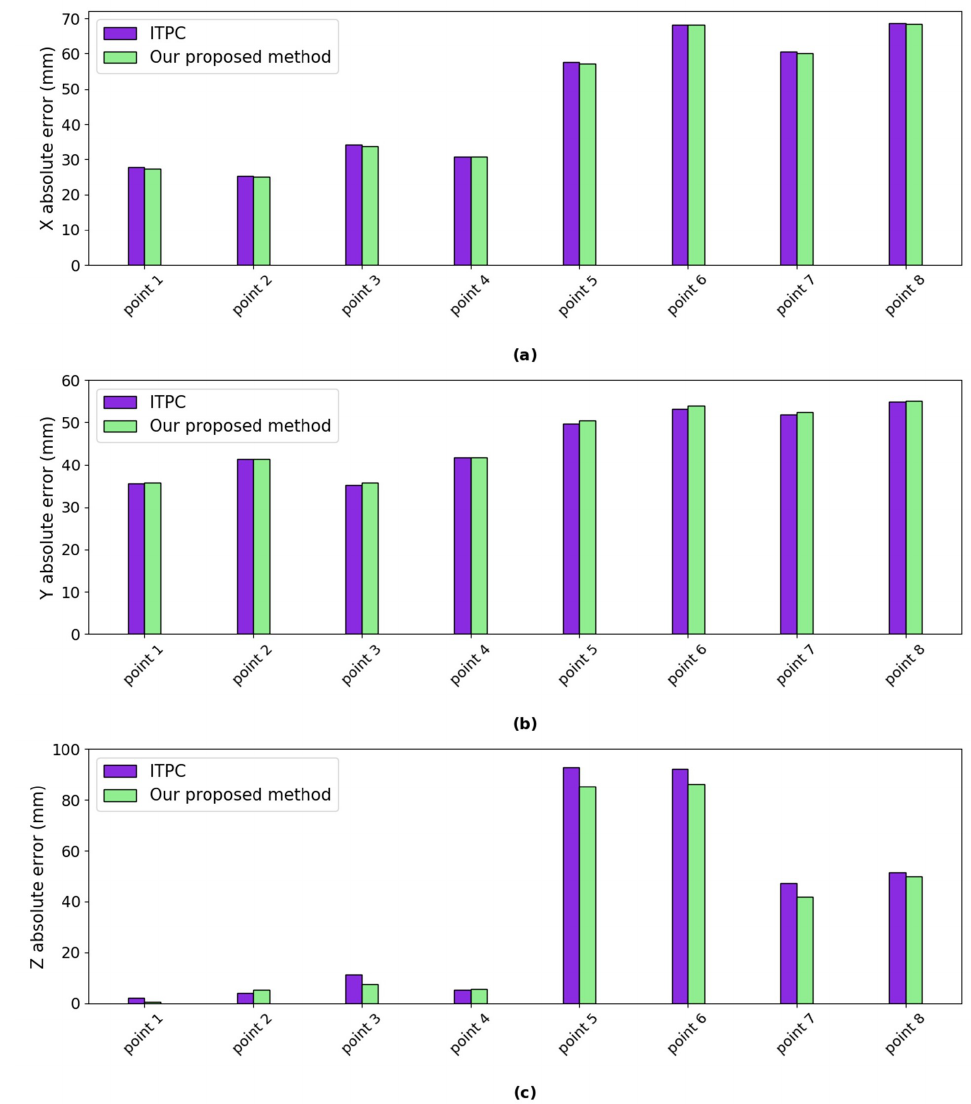
Figure 14. The absolute error of our proposed method and ITPC method w.r.t ZED Mini. ( a ) absolute error in X axis; ( b ) absolute error in Y axis; and, ( c ) absolute error in Z